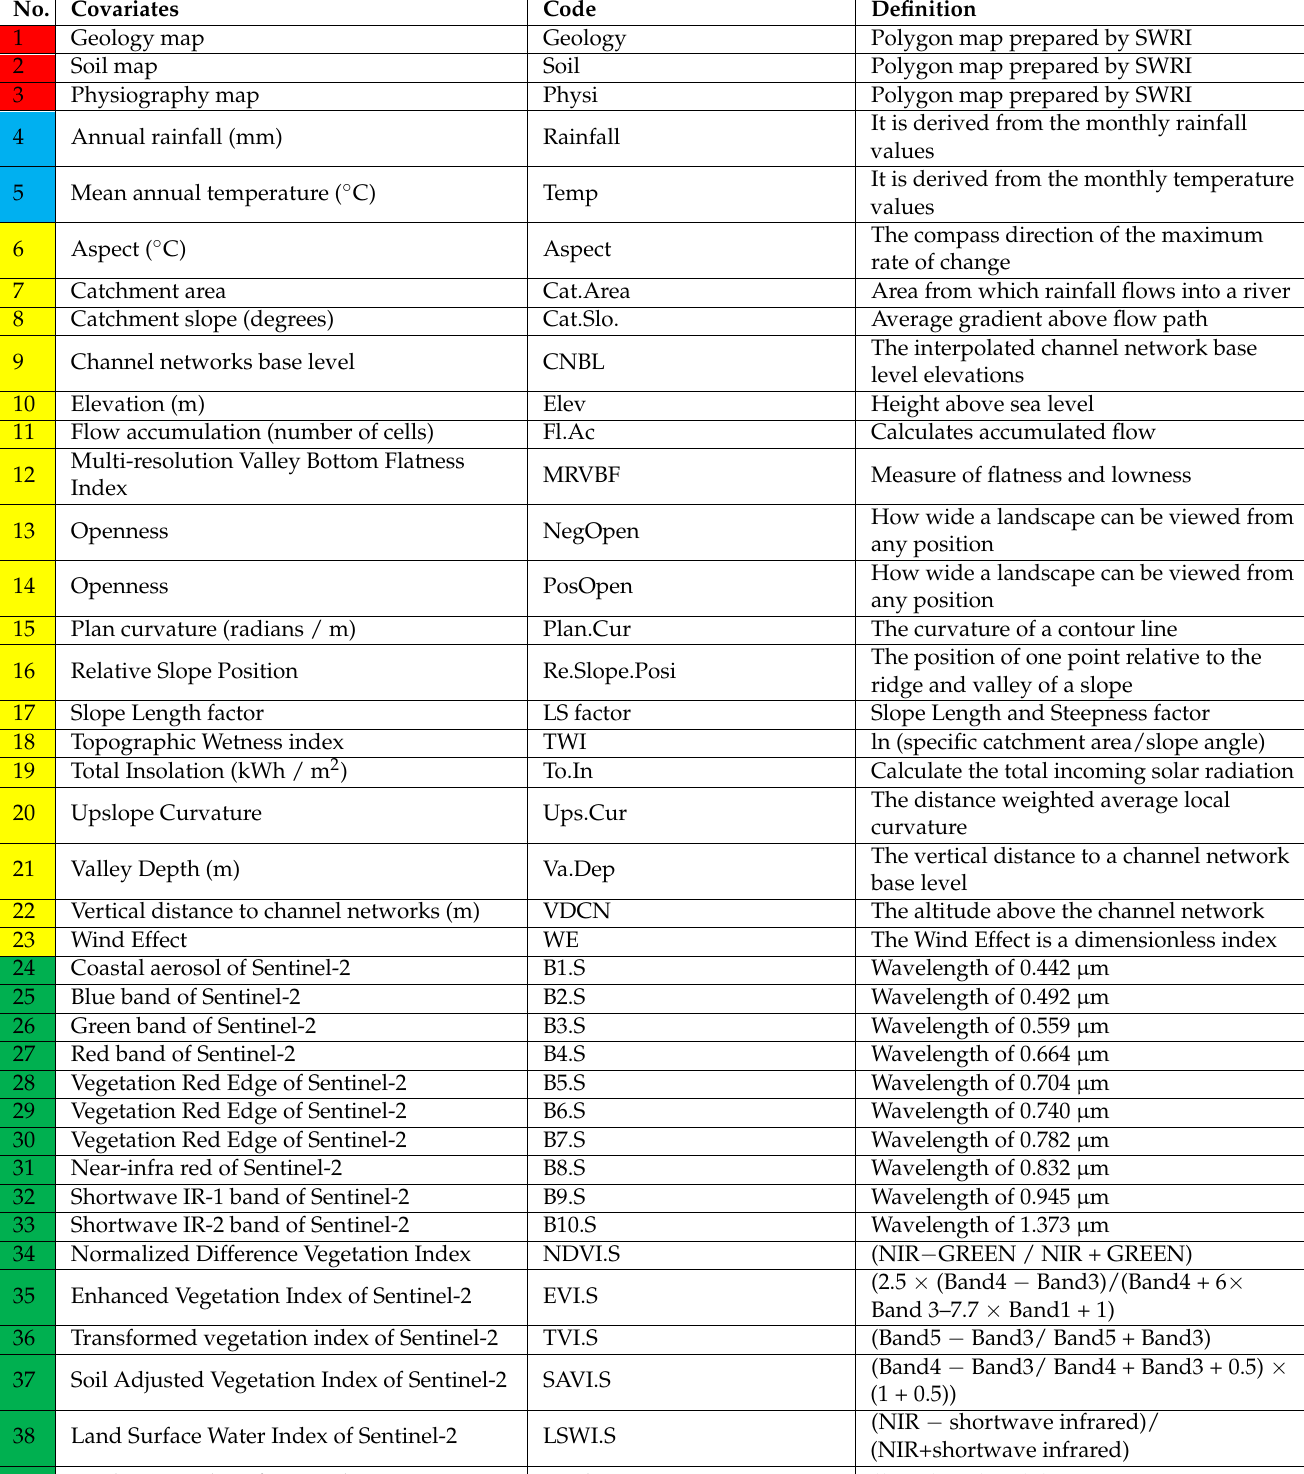
Table A1. Covariates initially considered for predicting the distribution of